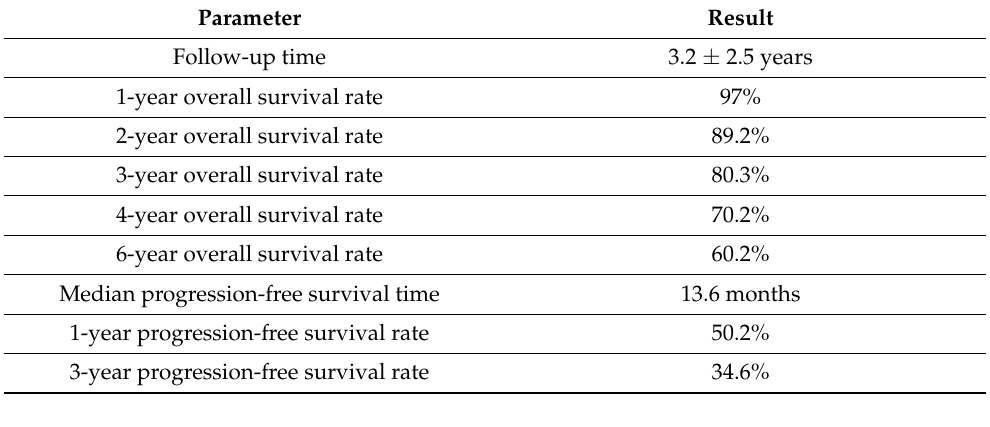
Table 3. Survival for all patients.